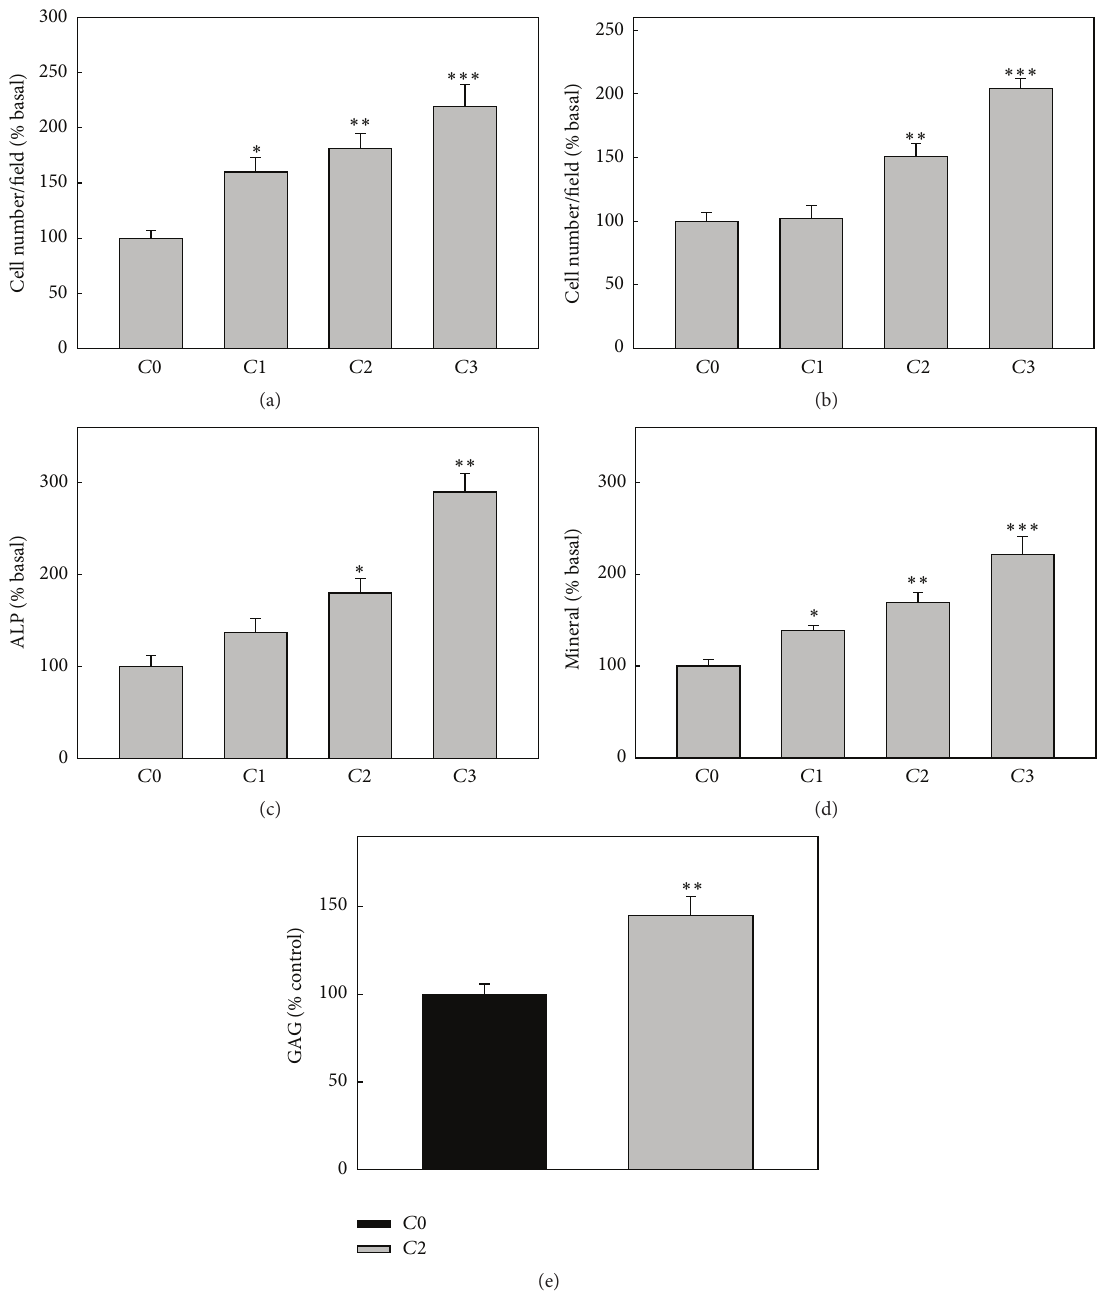
Figure 6: Biocompatibility of BMPC on 𝐶0 and VOAsc-loaded scaffolds: 𝐶1 : 10 𝜇 g/mL per cm 2 VOAsc; 𝐶2 : 20 𝜇 g/mL per cm 2 VOAsc; and 𝐶3 : 40 𝜇 g/mL per cm 2 VOAsc. Cells were plated on different collagen membranes and adhesion (1h (a)) and proliferation (24 h (b)) were evaluated by Giemsa staining. Cells in 10 representative fields per sample were counted and averaged. BMPC growing on different membranes were induced to be differentiated in osteogenic media: ALP (15 days (c)) or mineralization (21 days (d)) or chondrogenic media, GAG production (21 days (e)). Results are expressed as % of basal (cells differentiated in the 𝐶0 film) and they are expressed as mean ± SEM. ∗ 𝑝 < 0.05 ; ∗∗ 𝑝 < 0.01 ; ∗∗∗ 𝑝 < 0.001